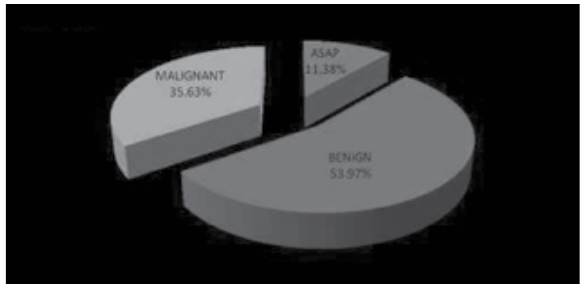
Figure 2 – Percentage of ASAP diagnosis per year from prostate biopsies performed by a public laboratory of pathology ASAP: atypical small acinar proliferation.